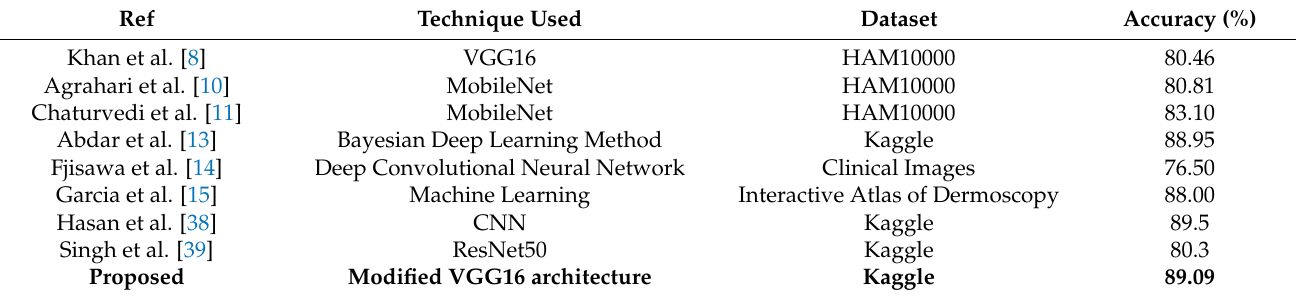
Table 7. Comparison of the Proposed Model with State-of-the-Art